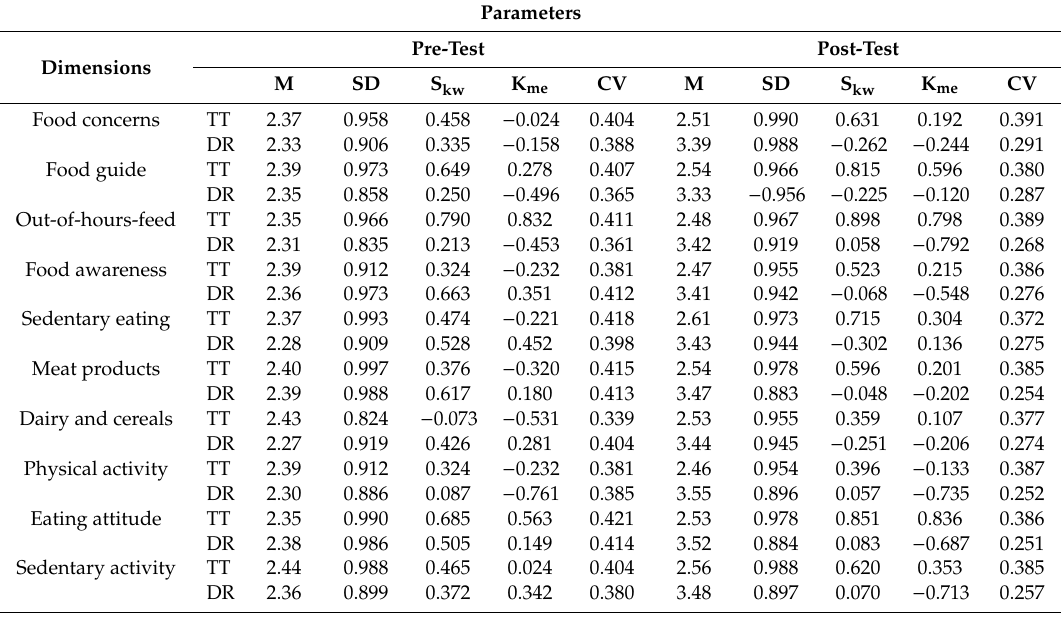
Table 1. Results obtained for the dimensions of study in TT and DR group of vocational